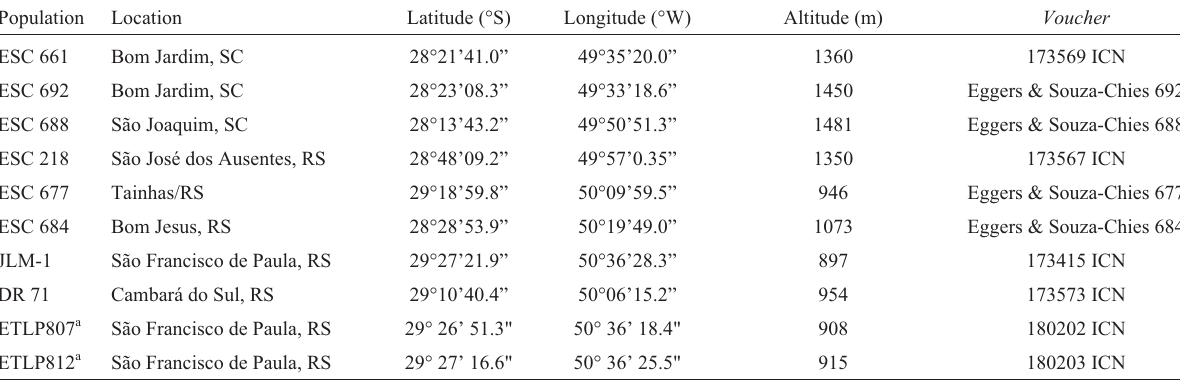
ESCindicatesthecollectorsEggersandSouza-Chies,followedbythenumberofthecollection,DRindicateDalRi,JLMcollectorJulianaLustosaMatos, ETLP indicates the collectors Eggers et al . ( a ) indicates the populations not included in molecular analyses.